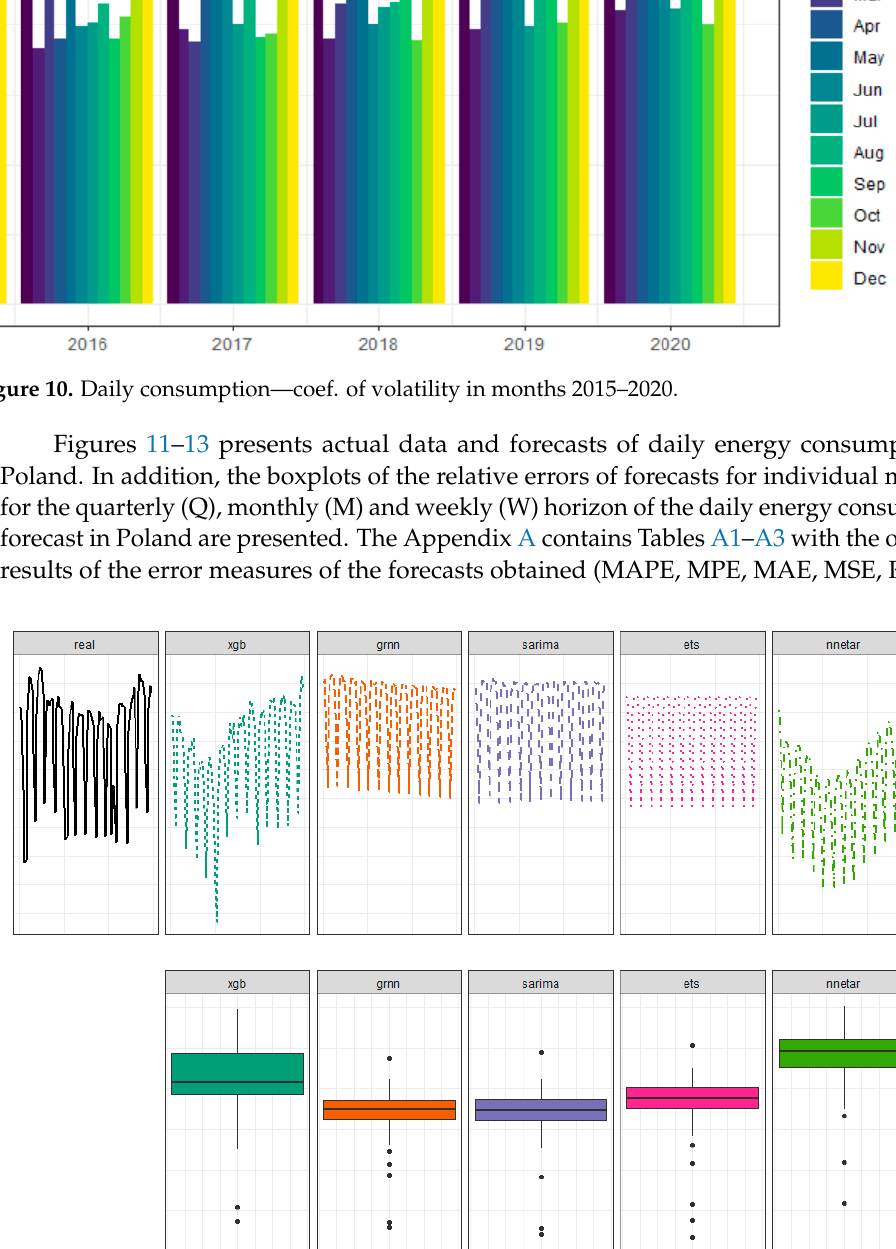
Figure 9. Daily consumption—standard deviation in months 2015–2020 (in GWh).